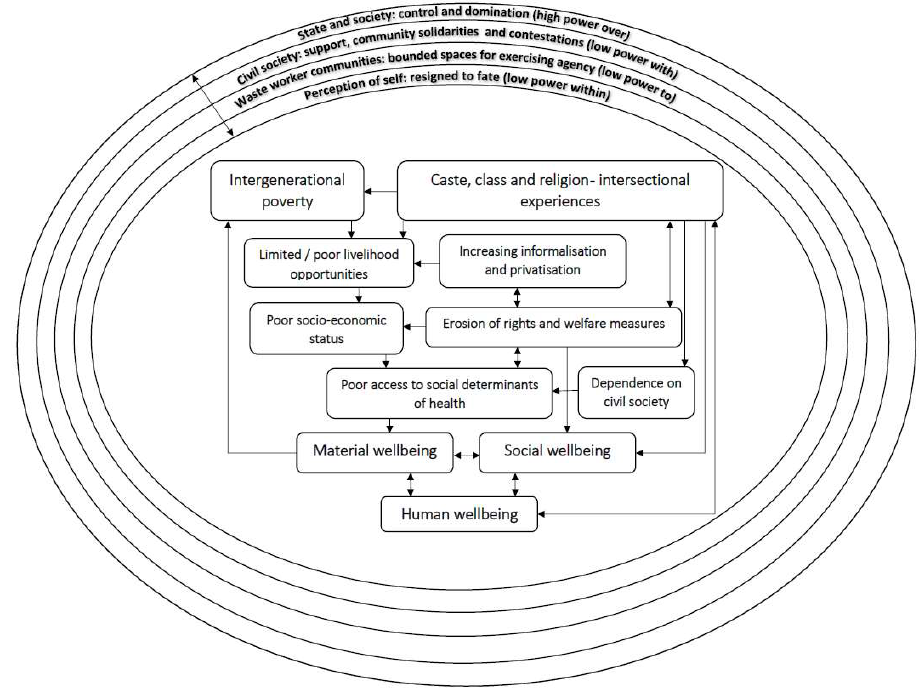
Figure 1. Synthesis of findings and conceptual framework.